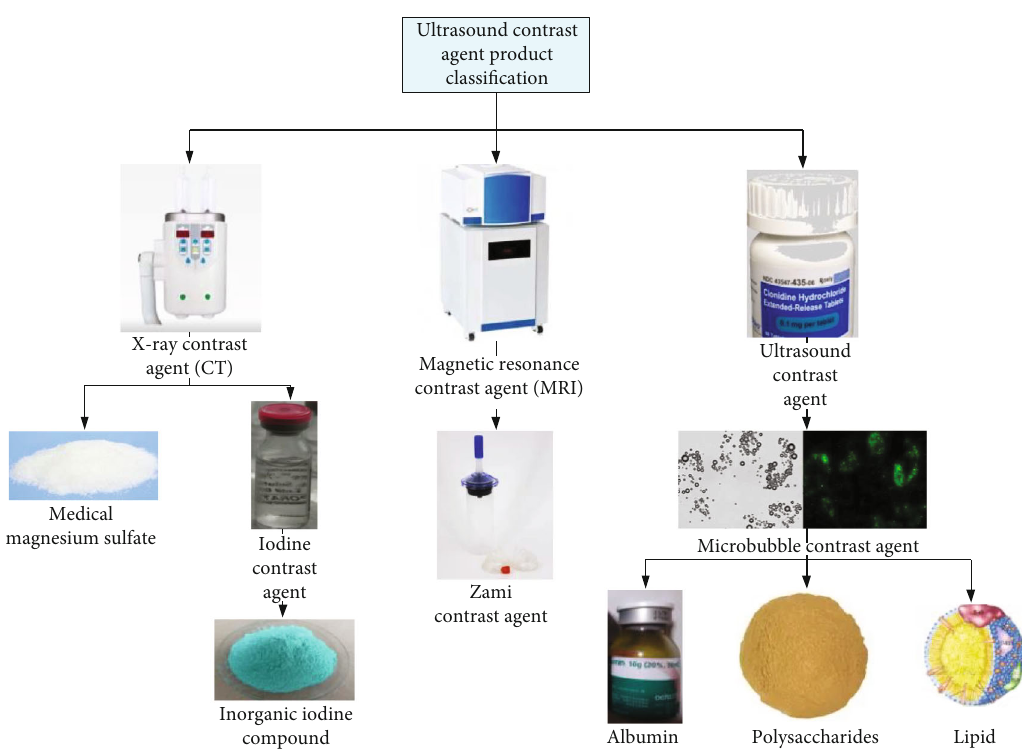
Figure 3: Contrast agent product classi fi cation.